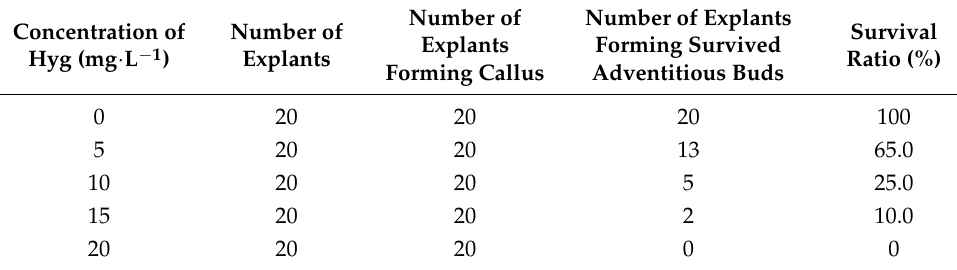
Table 4. The screen of Hyg selection pressure for commercial cultivar